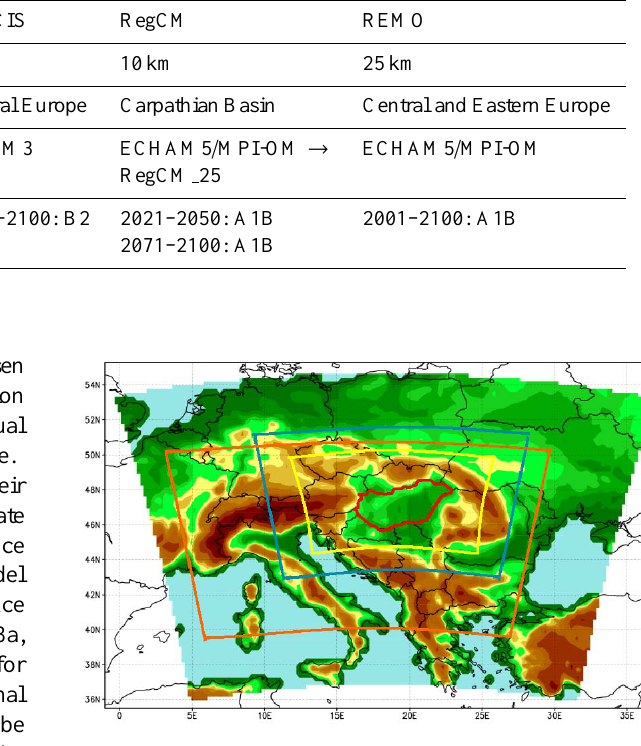
Fig. 2. Taylor diagram (normalised by the reference standard deviation) for monthly mean temperature (T: ERA-40-driven case, t: GCM-driven case) and precipitation values (R: ERA-40-driven runs, r: GCM-driven runs) over Hungary for 1961–1990. CRU data are used as observational dataset (represented by black dot).